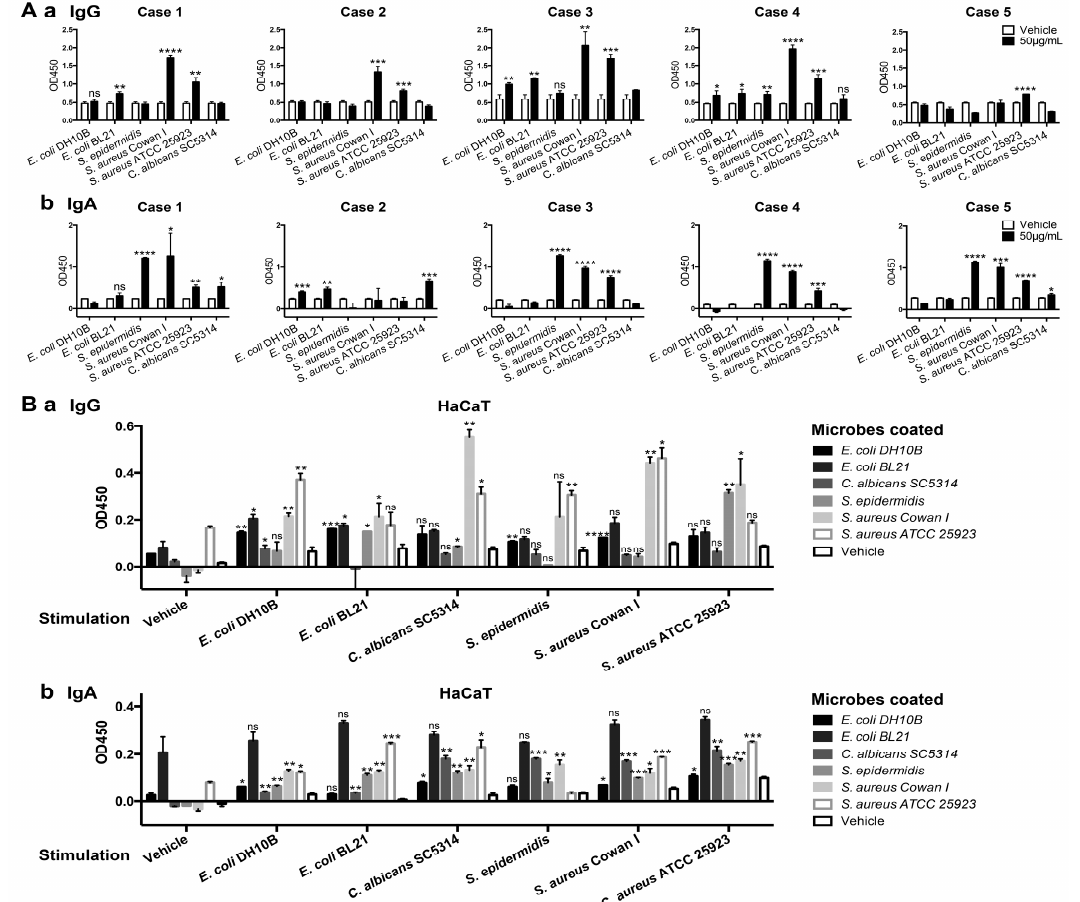
Figure 4. The binding of epidermis-derived IgG ( A ) and IgA ( B ) to E. coli strains DH10B and BL21, S. aureus strains Cowan I and ATCC 25923, clinical isolated strain of S. epidermidis , and C. albicans strain SC5314 was analyzed by ELISA. ( A ) Binding of IgG ( a ) and IgA ( b ) in epidermis tissue lysates from five healthy donors to microbes was analyzed by ELISA. 50μg/mL microbes were coated for testing Ig binding, vehicle as negative control. Data are presented as mean ± SD. Student’s t -tests were performed when mean of microbes-coated group was higher than vehicle control. Statistical significance: ns means no significant difference, * p < 0.05, ** p < 0.01, *** p < 0.001, **** p < 0.001 vs. vehicle control; ( B ) The microbial-binding activity of secreted IgG ( a ) and IgA ( b ) by HaCaT was analyzed by ELISA. Cell culture supernatant was collected 24 h after stimulation with different microbes (50 μg/mL). IgG and IgA with microbial-binding activity were captured from the supernatant by different microbes coated at 50 μg/mL and were detected with anti-IgG and anti-IgA antibodies, respectively. All data are calibrated by minus OD450 of culture medium control and presented as mean ± SD. Student’s t -tests were performed when mean of microbe stimulation group was higher than vehicle stimulation control. Statistical significance: ns means no significant difference, * p < 0.05, ** p < 0.01, *** p < 0.001, **** p < 0.001 vs. vehicle stimulation